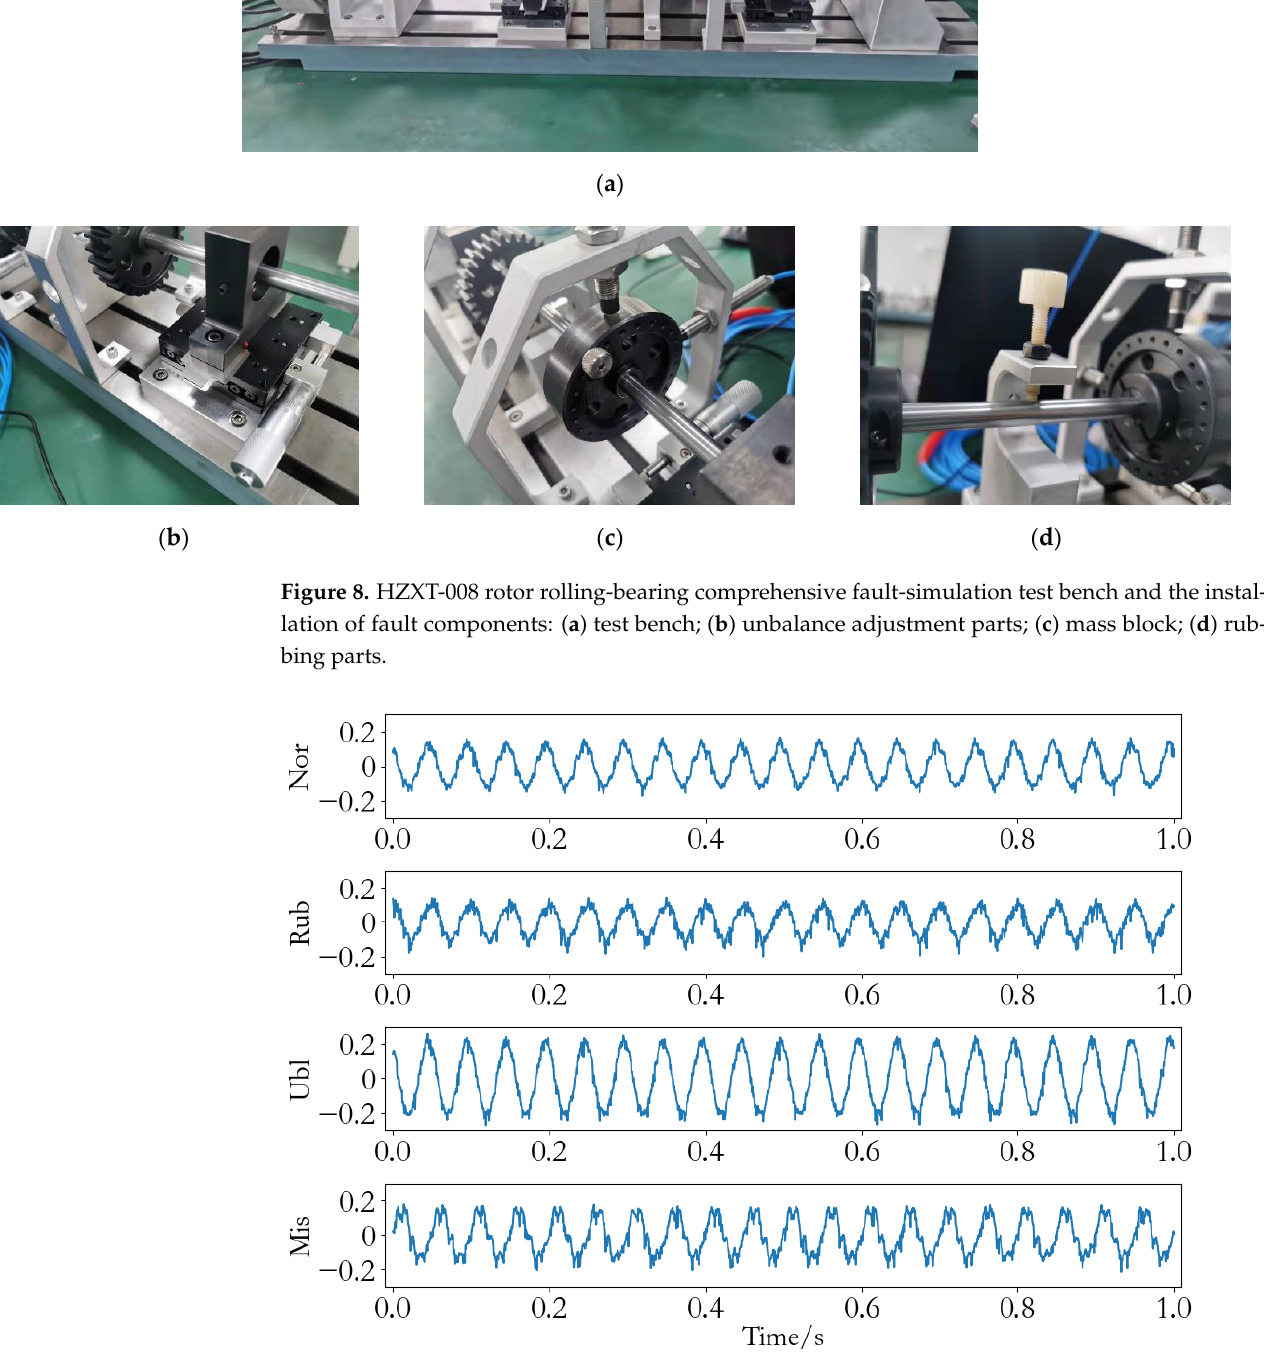
Figure 9. Vibration signals in different states.